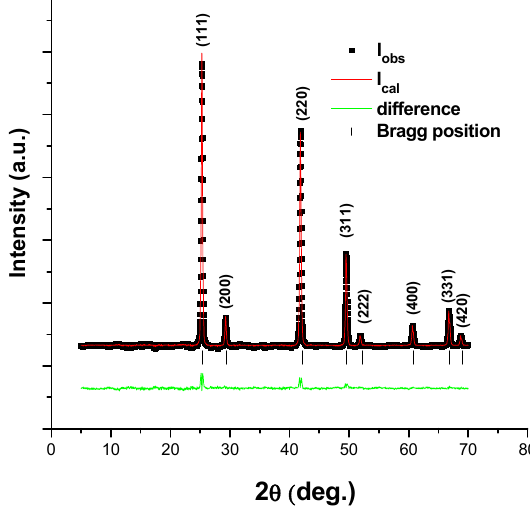
Figure 2. Rietveld refinement of ZnTe powder sample.